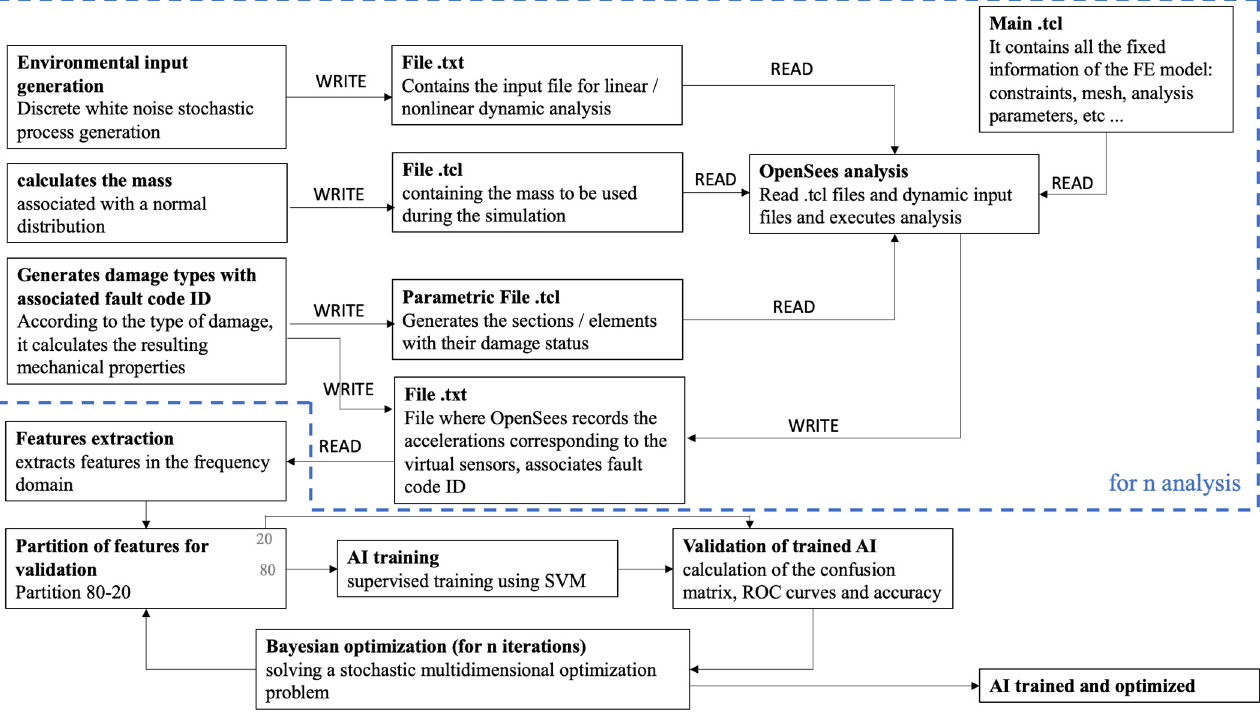
Figure 2. Framework for machine learning training.